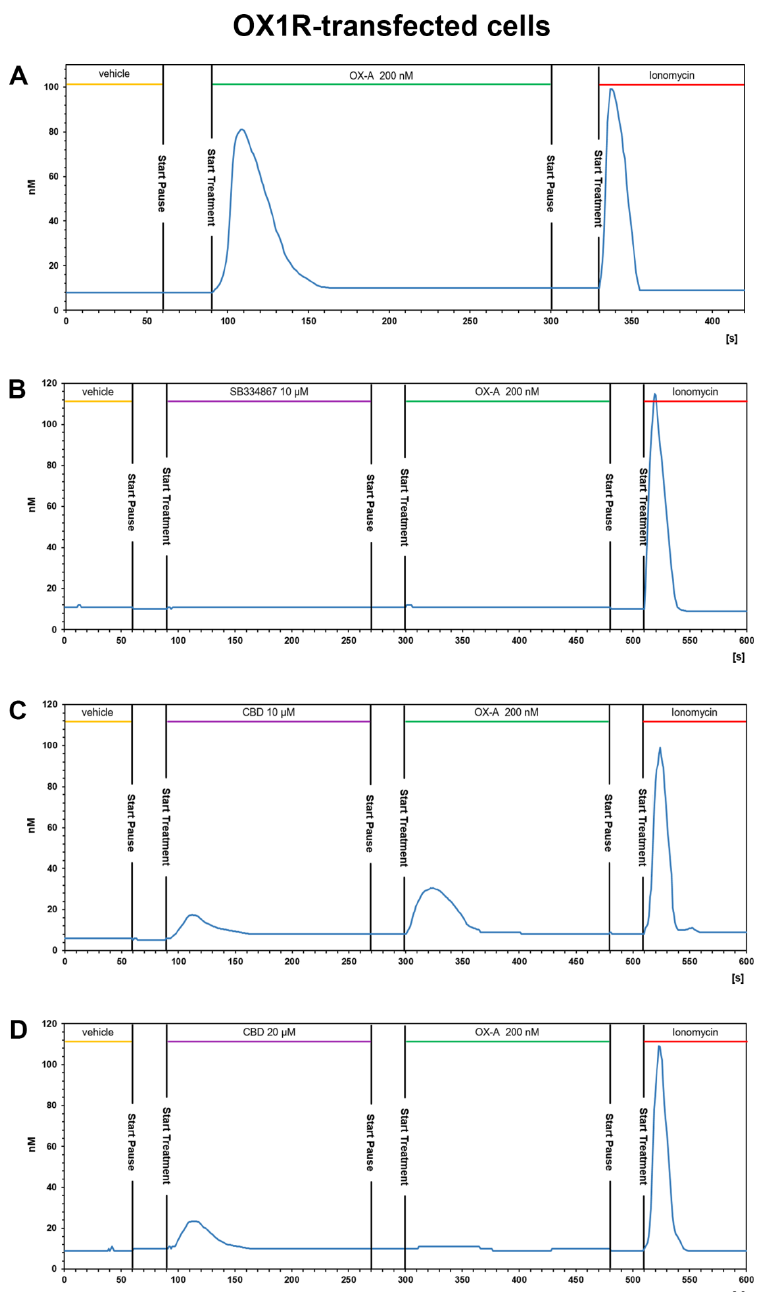
Figure 4. CBD prevents the OX-A-induced [Ca 2+ ] i response in CHO cells expressing OX1R. Repre- sentative traces of single-cell [Ca 2+ ] i response in Fura-2- loaded CHO cells stably expressing